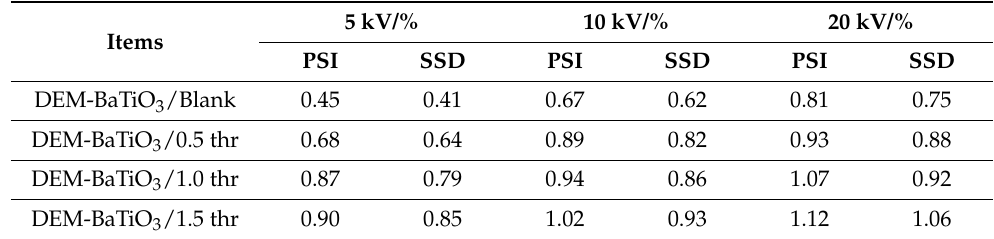
Table 6. Electro deformability data for the actuating unit under different electrode coating